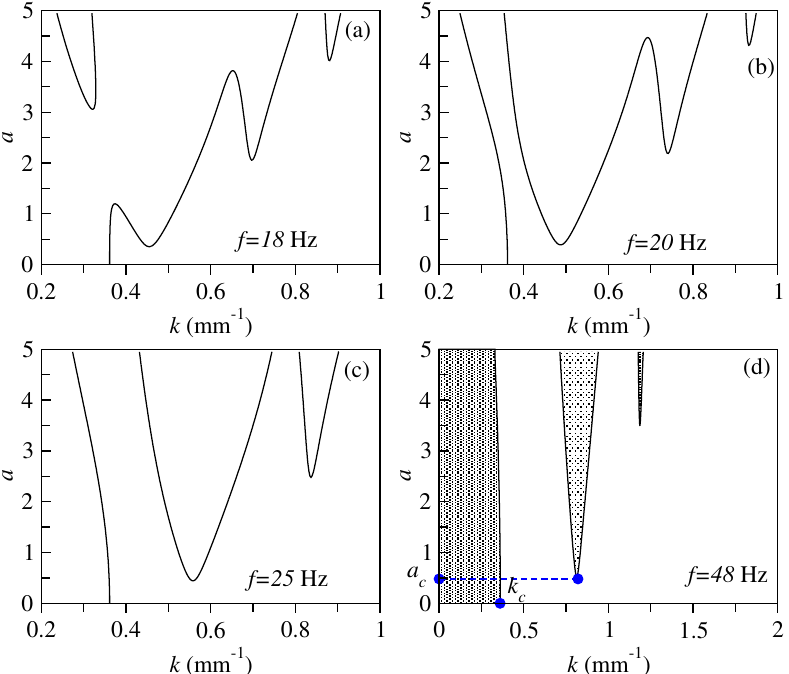
Figure 6. Marginal stability curves of the base flow Equation(2) for a 0.6mm water film on a θ = 3 o incline vibrated at ( a ) f = 18Hz, ( b ) f = 20Hz, ( c ) f = 25Hz and ( d ) f = 48Hz. The shaded regions in panel ( d ) highlight the unstable areas, k c indicates the critical wavevector of the gravitational long-wave instability Equation(3), and a c marks the critical vibration amplitude when the Faraday instability sets